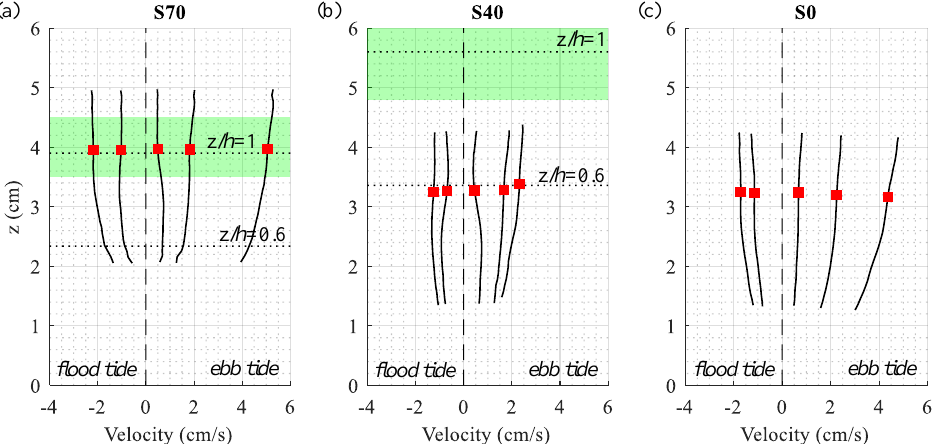
Figure 4. Representative nearshore velocity profiles measured over a single tidal cycle. Solid lines show velocity profiles measured at the S70 ( a ) S40 ( b ) and S0 ( c ) sample sites, and shaded green boxes represent 95% CI on the local seagrass height. Horizontal dotted lines represent elevation above bed (z) to canopy height ( h ) ratios of z/ h = 1 and z/ h = 0.6. The elevation of reported turbulence metrics and velocity attenuation is shown with a red square, which represents the most accurate portion of the instrument sample volume.